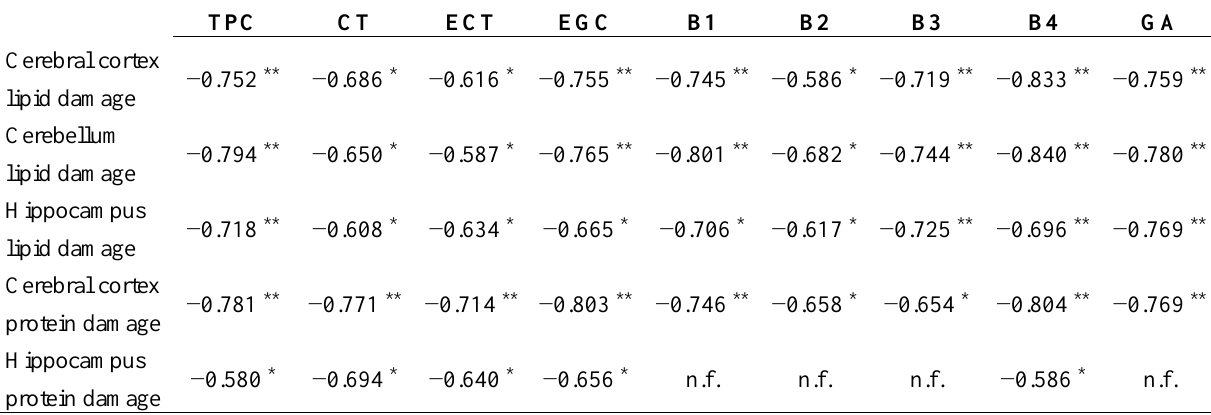
Table 4. Pearson correlations and their statistical significance among the wine waste extract constituents and oxidative parameters evaluated. TPC